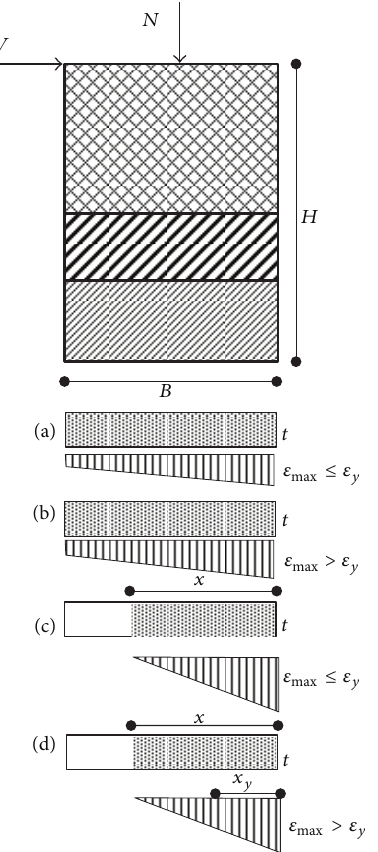
Figure 1: States characterizing the behavior of the cross-sections composing the